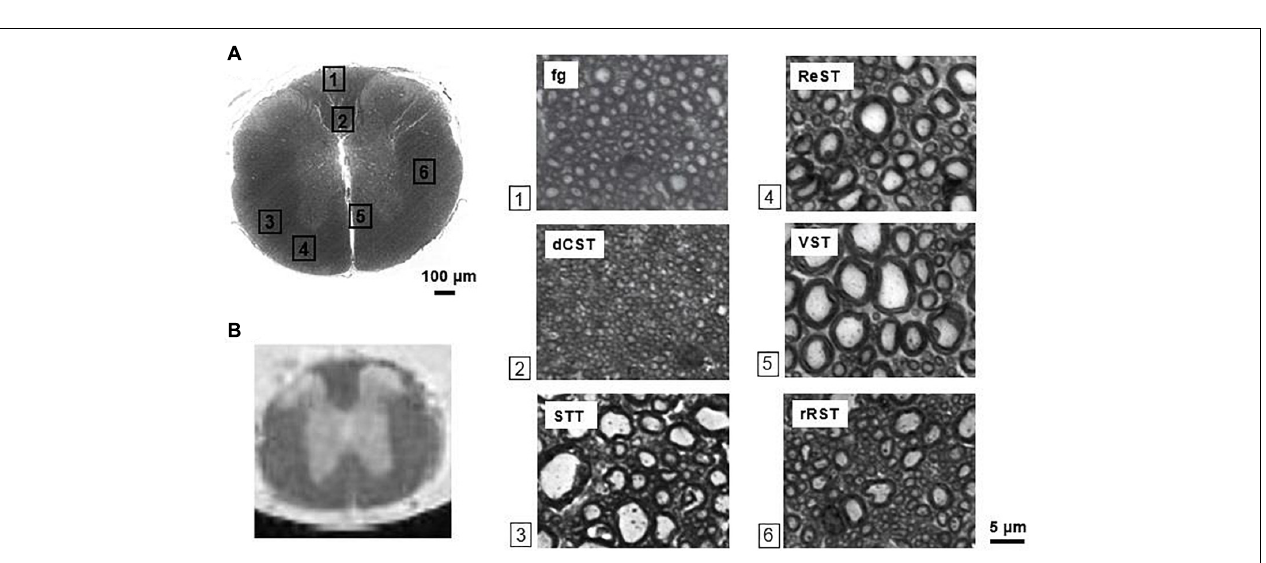
FIGURE 3 | Mouse spinal cord histology. (A) Optical image of the thoracic segment at the level T3/T4, with magnifications ( × 100) of selected white matter tracts. The scalebar is indicated (bar = 5 µ m for each magnification). (B) T2-weighted image showing the corresponding slice. The ventral side of the cord is adjacent to the